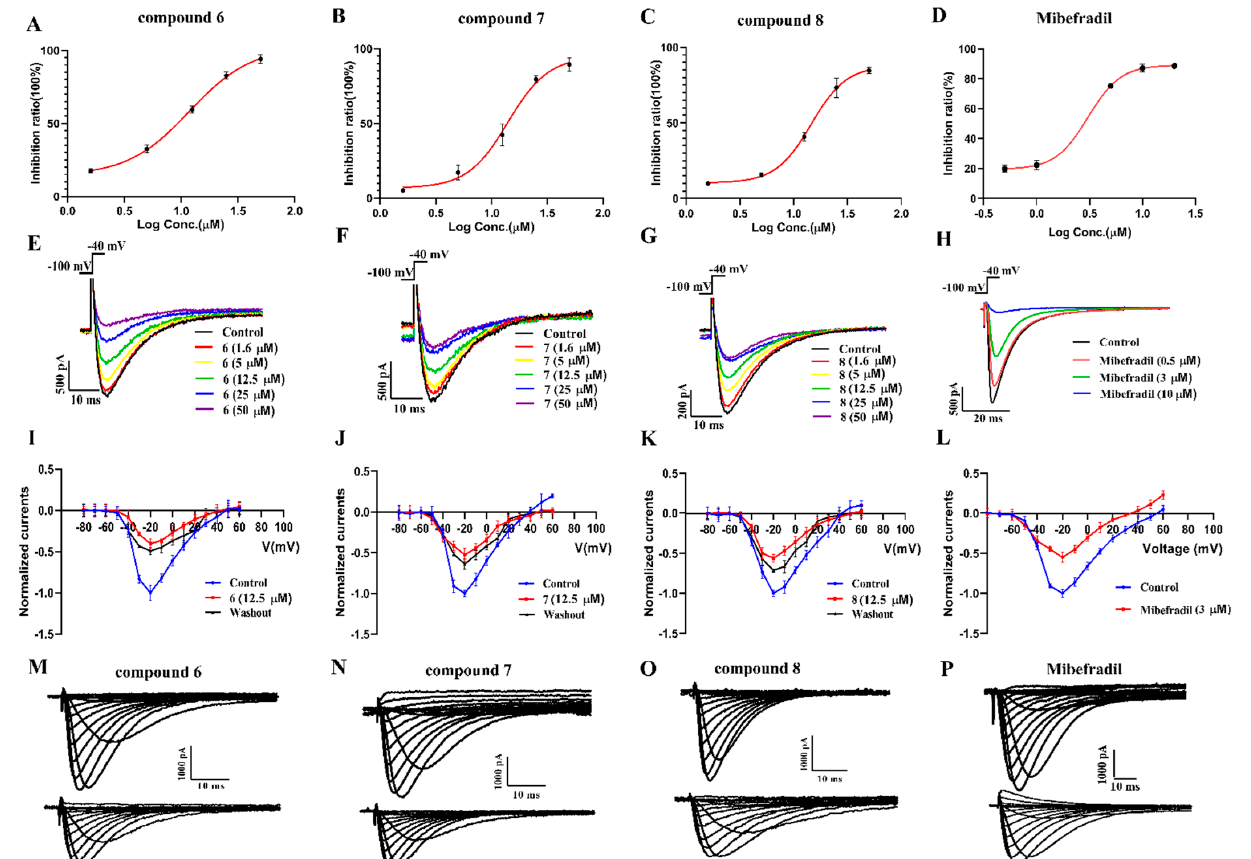
Figure 6. Effects of compounds 6 – 8 and the positive control (mibefradil) on current of Ca v 3.1. ( A – D ) Dose-responsive curves of 6 - 8 and mibefradil on peak current of Ca v 3.1. Data points represent mean ± SD of three or four repetition measurements. Solid curve represents fit to the Hill equation. ( E – H ) Representative Ca v 3.1 peak current traces in the absence and presence of different concentrations of 6 – 8 and mibefradil. ( I – L ) Normalized I-V curves of Ca v 3.1 control (blue), Ca v 3.1 with 12.5 μ M 6 – 8 (red), 3 μ M mibefradil, and washout (black). All the data were represented as mean ± SD ( n = 3). ( M – P ) Current traces obtained with Ca v 3.1 at various membrane potentials (from − 80 to +60 mV in 10 mV increasement at 4 s intervals) from a holding potential of − 100 mV (upper panel). Current traces obtained with Ca v 3.1 with 6 – 8 (12.5 μ M) and mibefradil (3 μ M) using same stimulating voltages (lower panel).